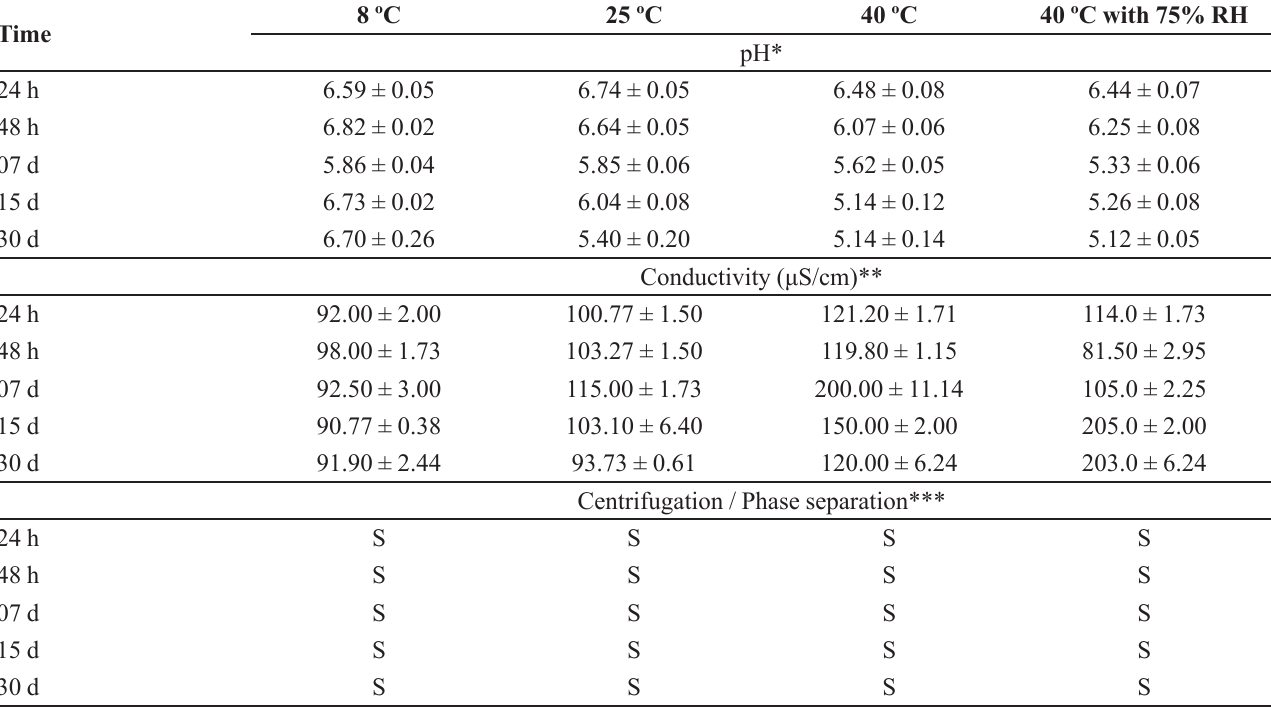
TABLE II - Centrifugation, Mean conductivity and pH values of MeA samples kept in different storage conditions